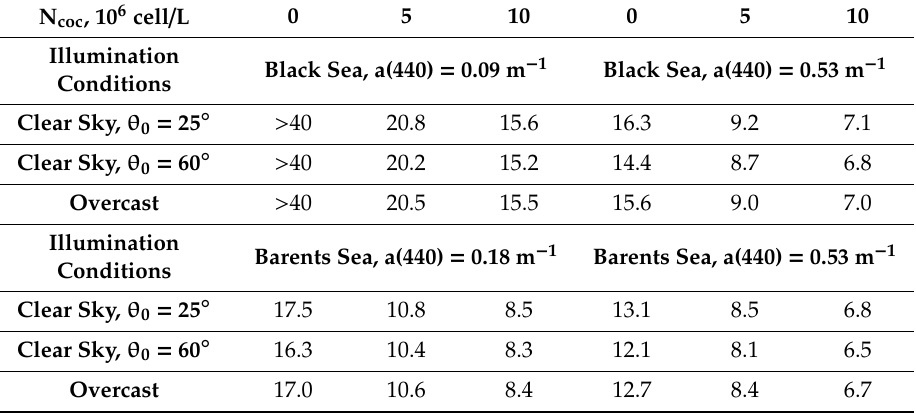
Table 5. The depth of the photic layer Z 1% (m) for λ = 500 nm, in the cases of the Black Sea and Barents Sea, depending on the value of N coc , the illumination conditions, and the absorption coe ffi cient. N coc , 10 6 cell /